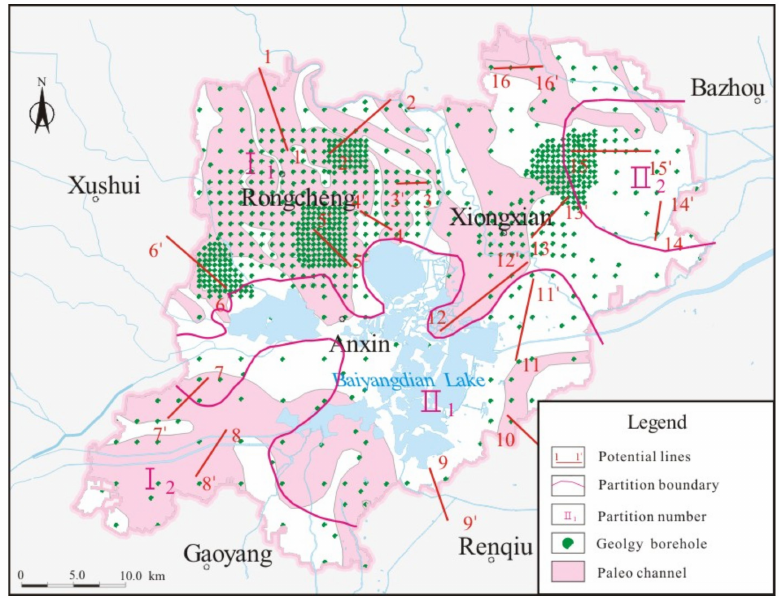
Figure 7. Modified paleo-channel distribution map in Qp 2 based on the results of boreholes and chemical